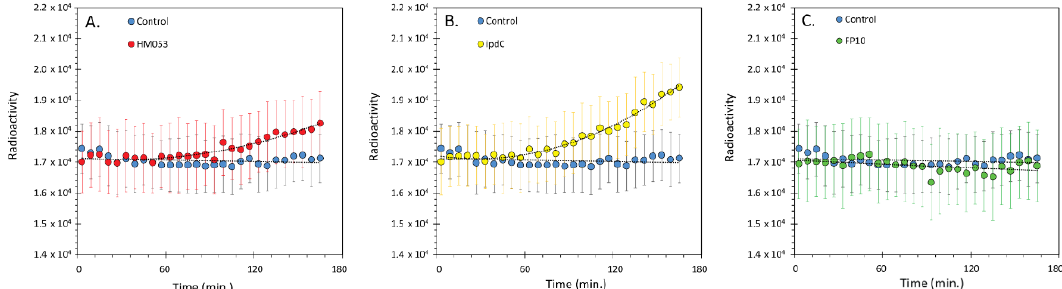
Figure 2. Dynamic 65 Zn transport over ~3-hours of acquisition. The data reflect 65 Zn transport measured by a radiation detector located along the plant stem at approximately 8 cm from the base of the stem. Each data point represents a 5-minute average ± SD of 300 data points sampled at 1 Hz across 5-6 biological replicates. (Panel A ): Transport of 65 Zn in HM053-inoculated plants is shown in red with the non-inoculated control data shown in black. (Panel B ): Transport of 65 Zn in ipdC inoculated plants is shown in yellow, with the non-inoculated control data shown in black. (Panel C ): Transport of 65 Zn in FP10 inoculated plants is shown in green, with the non-inoculated control data shown in black. In all cases, data were normalized to the same starting level of radioactivity for direct comparison of transport across the bacteria strains. Data were fitted to trendlines (depicted by the dashed lines).